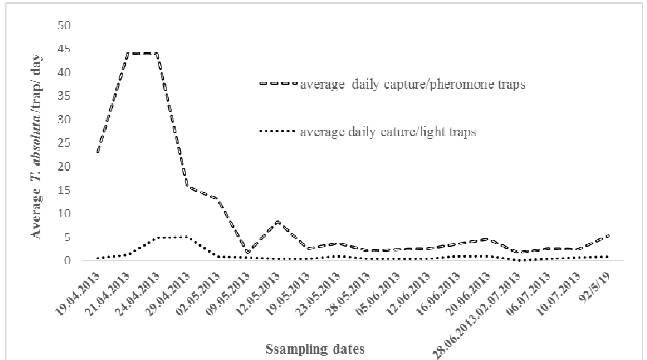
Fig. 2. Population fluctuations of T. absoluta adults in traps containing sex pheromone and traps lacking sex pheromone